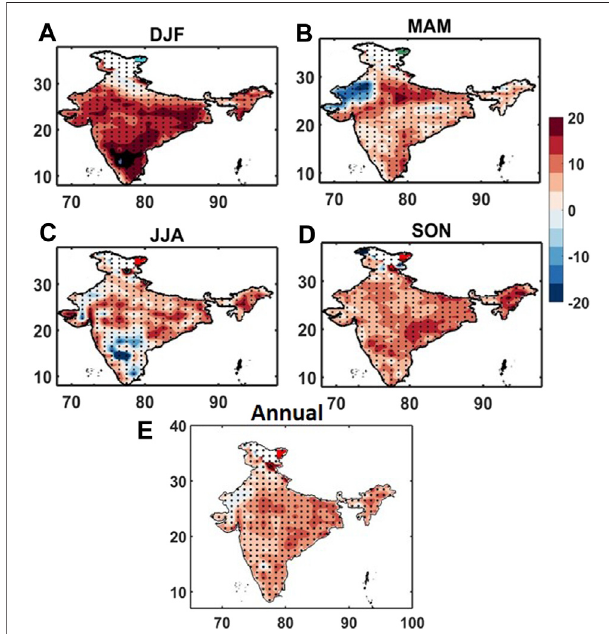
FIGURE 4 | Variation of SDR in percentages (%) over the Indian region for (A) Winter (DJF), (B) Pre-monsoon (MAM), (C) Monsoon (JJA), (D) Post- monsoon(SON),and (E) Annual.Theblackdotsdenotestatisticalsigni fi cance at a 95% level.